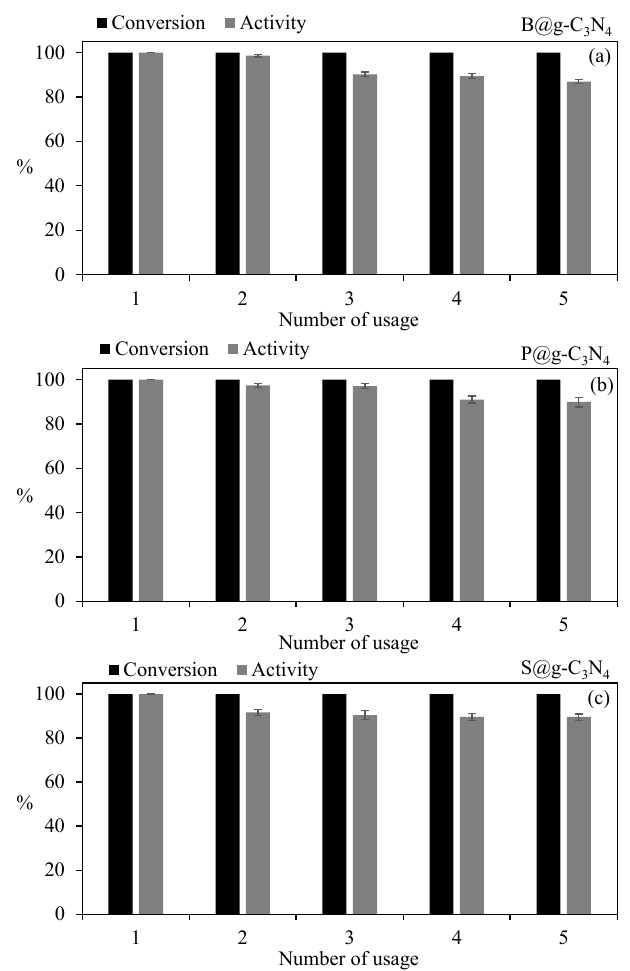
Figure 5. The reuseability of ( a ) B@g-C 3 N 4 , ( b ) P@g-C 3 N 4 , and ( c ) S@g-C 3 N 4 catalysts in dehydro- genation reaction of NaBH 4 in methanol [reaction condition: 50 mg catalyst, 20 mL methanol, 0.0965 g NaBH 4 , 40 ◦ C, 1000